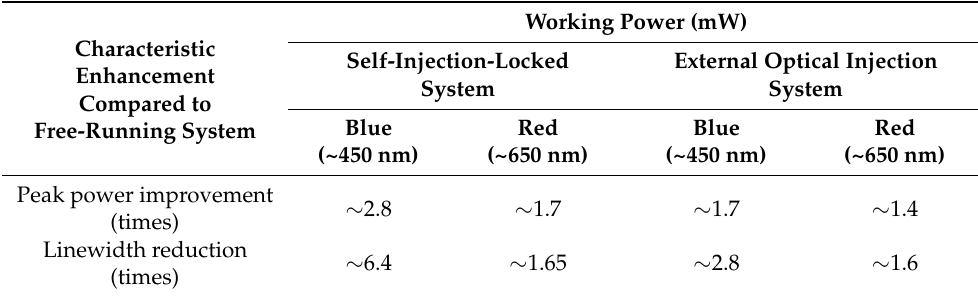
Table 3. Comparison of the characteristic enhancements of blue and red LDs in SIL and external optical injection cases